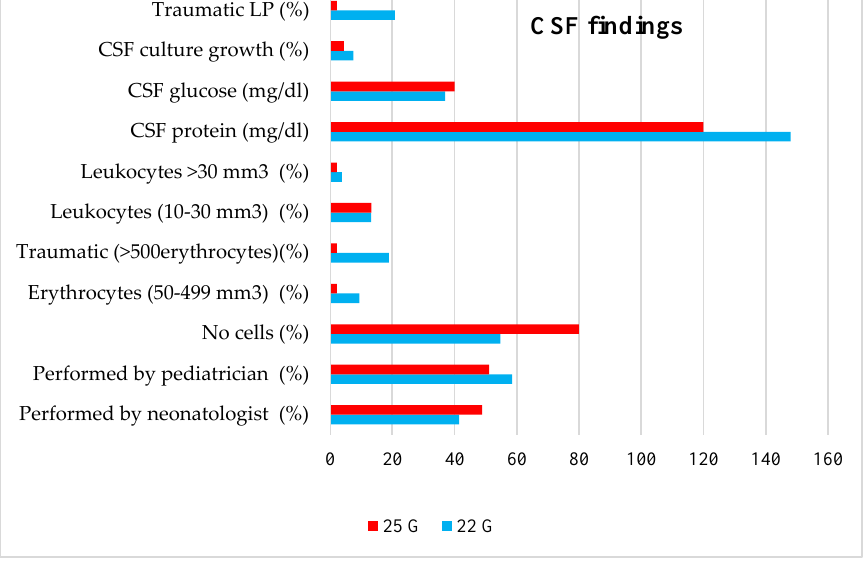
Figure 2. LP findings by needle sizes.